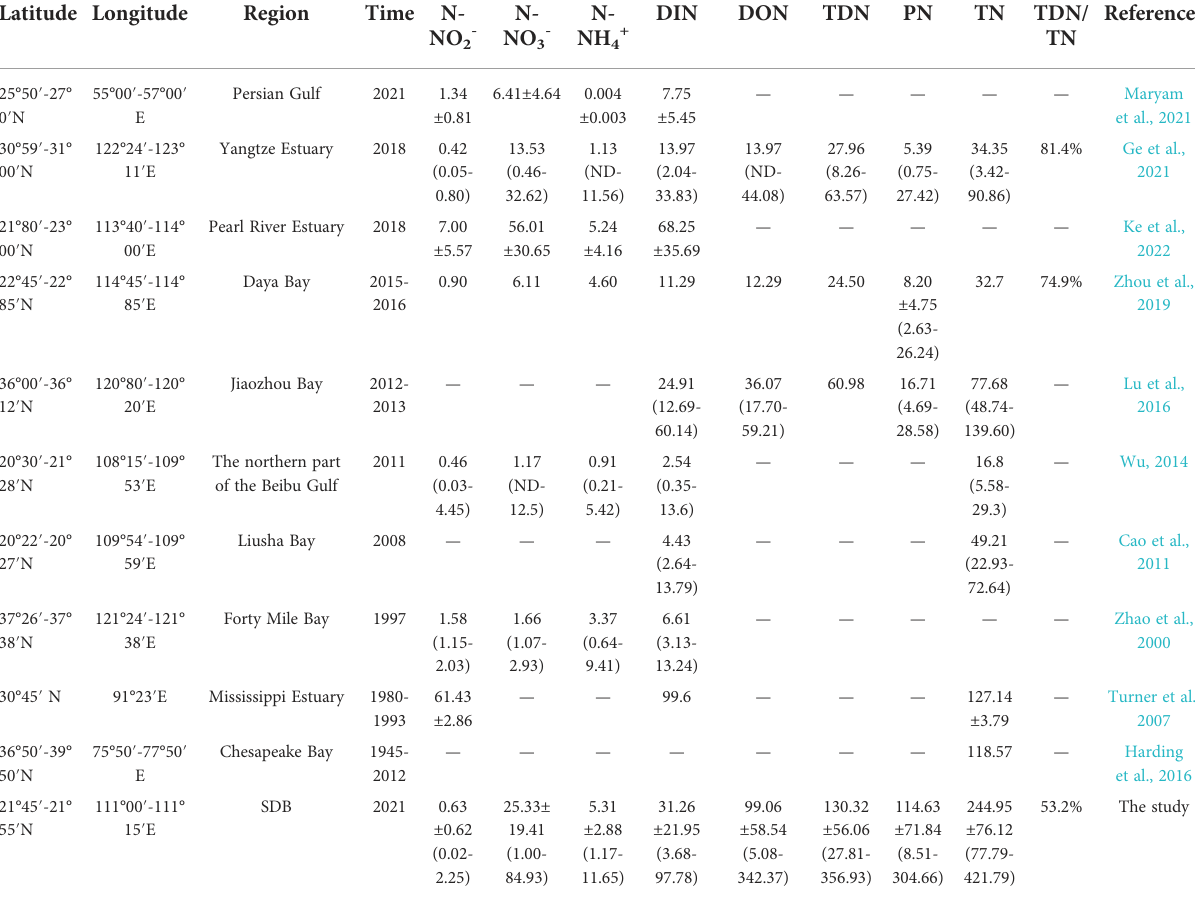
TABLE 3 Nitrogen species in SDB and its adjacent waters and bays around the world ( m mol/L). Latitude